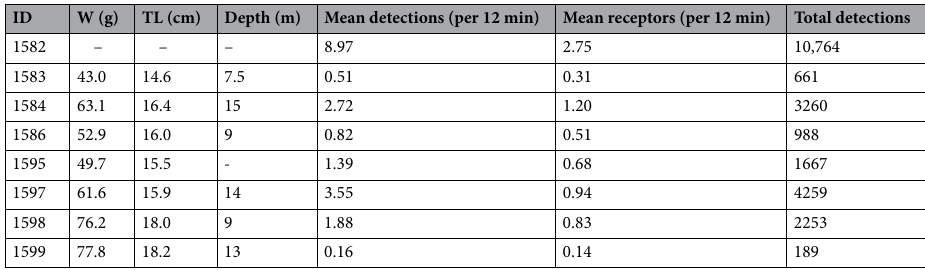
Table 1. Fish biometrics and tracking data detections during the study period. By columns: individual unique identifier (ID); biometric measures for each fish, weight in grams and total length in centimetres (W and TL respectively); capture and release depth in meters (Depth); mean number of detections every 12 min per individual (Mean detections); mean number of receptors that detected each individual every 12 min (Mean receptors); total number of detections per individual during the 10 days of the study period (Total detections). (−) Means no data